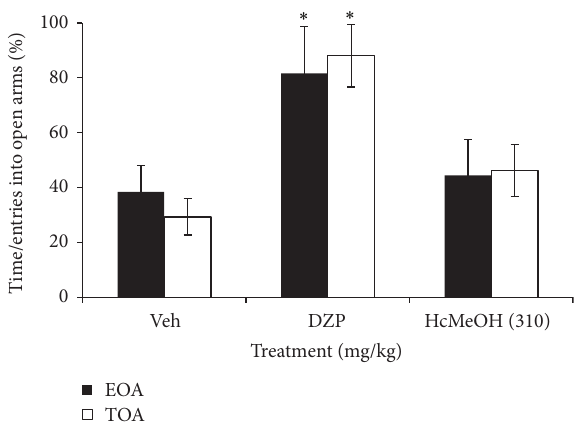
Figure 4: Effect of oral administration of Heteropterys cotinifolia methanolic extraction the percentage of time spent in open arms (TOA) and entries into open arms (EOA) by mice exposed to EPM. ∗ 𝑃 < 0.05 in ANOVA followed by a post hoc Dunnett test (mean ± S.D.). Veh, vehicle; DZP, diazepam; HcMeOH, methanolic extract of Heteropterys cotinifolia .